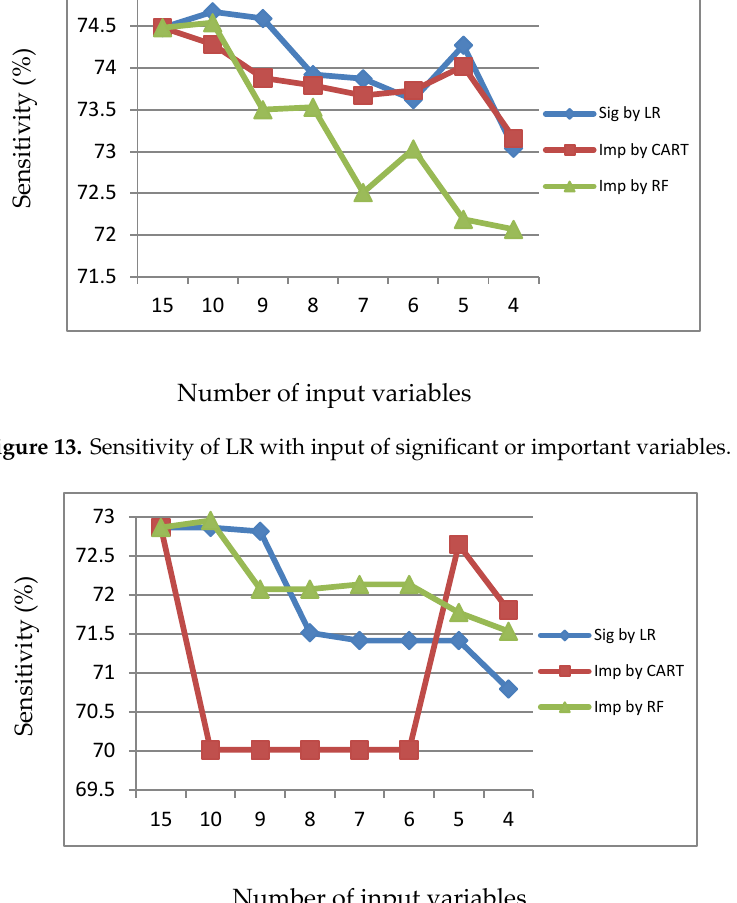
Figure 15. Sensitivity of RF with input of significant or important variables. 3.3.3. Specificity of LR, CART and RF with Input of Significant or Important Variables In Table 4 it is seen that the specificity (72.95%) of RF is higher than LR and CART when inputting the 15 original variables. For another analytical point of view, specificity of different LR, CART and RF models is shown in Figures 16–18, corresponding to input of different groups of significant variables identified by LR or important variables identified by CART or RF, respectively. It is seen that the specificity (75.5%) of CART with input of 6 to 10 important variables identified by CART is the highest specificity in this study, and the specificity of CART with input of four to eight significant variables identified by LR is higher than the highest specificity (72.95%) when inputting the 15 original variables. In addition, it is seen that the specificity of RF with input of four to ten significant variables identified by LR, six to ten important variables identified by CART or ten important variables identified by RF are all higher than 72.95%. This means that CART and RF models are efficient prediction models for specificity. In other words, if CART is input with either some important variables identified by CART or significant variables identified by LR, and RF is input with either some significant variables identified by LR or important variables identified by CART or RF, then their specificity will be promoted.